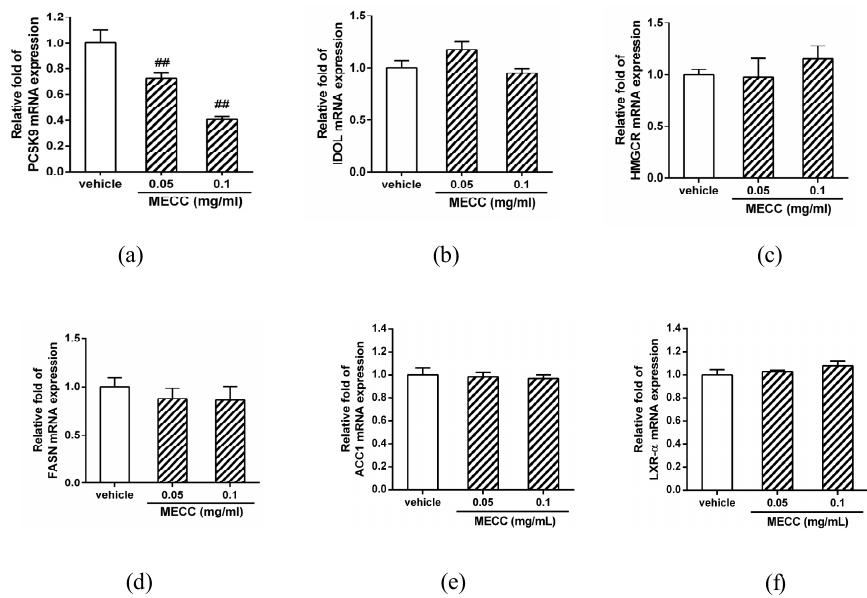
Figure 4. Effects of MECC on the expression of cholesterol homeostasis- and lipogenesis-related genes. HepG2 cells were cultured in LPDS medium and treated with vehicle (0.1% DMSO) or MECC (0.05 and 0.1 mg/mL) for 24 h. Cellular RNA was prepared, and the mRNA expression of the ( a ) PCSK9 ( b ) IDOL ( c ) HMGCR ( d ) FASN ( e ) ACC1 and ( f ) LXR- α was determined by reverse transcription real-time PCR. The data are presented as the means ± SD from three independent experiments. ## p < 0.01 represent significant differences compared to the vehicle-treated group.